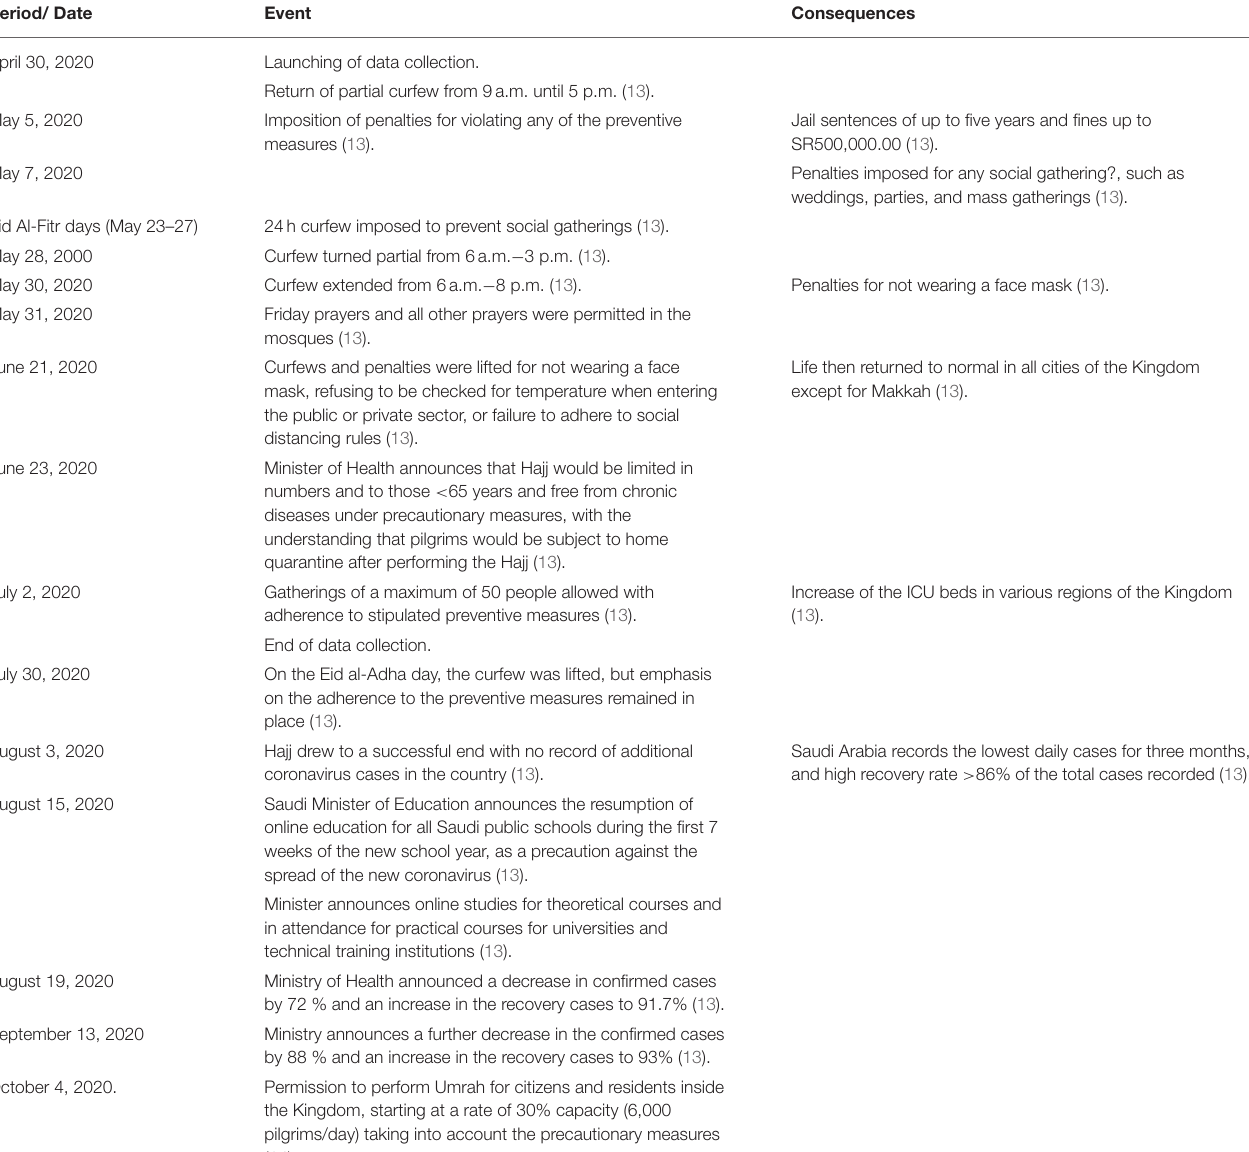
Table 1 | Sequence of events in fighting COVID-19 during the study period (13,